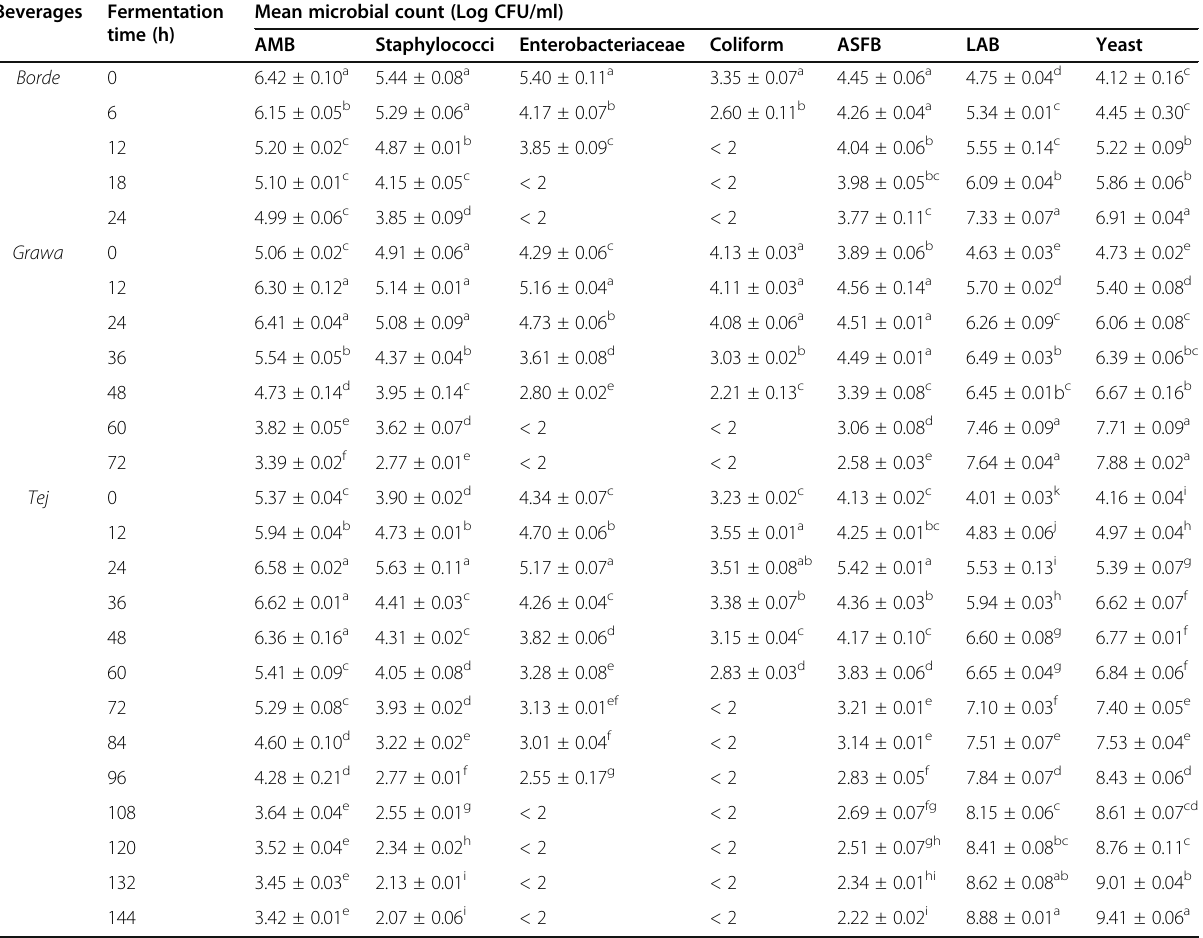
Table 1 Microbial dynamics (mean ± SD) during fermentation of selected Ethiopian traditional fermented beverages Beverages Fermentation time